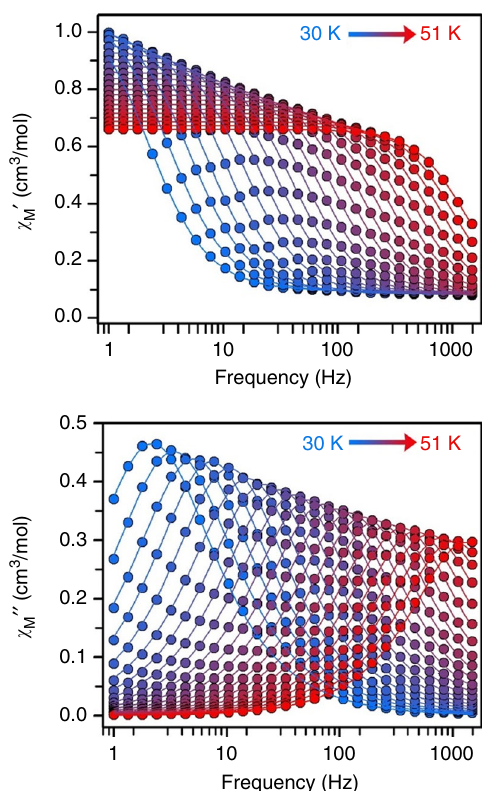
Fig. 3 Dynamic magnetic susceptibility data. Variable-temperature, variable-frequency in-phase ( χ M ′ ) and out-of-phase ( χ M ″ ) ac magnetic susceptibility data collected for 2-Tb under a zero-applied dc fi eld from 30 to 51 K. A non-zero χ M ″ out-of-phase signal suggests the presence of an energy barrier to spin reversal. Fits of a generalized Debye function to the χ ′ and χ ″ data afforded the relaxation times; solid lines represent fi ts to M M the data. Low and high-frequency ac magnetic susceptibility data are shown in the Supplementary Figs. 46 and isostructural compounds 2-Tb and 2-Dy are THF-free, resulting in decreased metal coordination numbers and increased Ln – N 2 3 − – Ln dihedral angles of 178.5(2)° and 178.9(3)°, compared to 173.45(16)° and 173.14(8)° in 1-Tb and 1-Dy , respectively (Fig. 1 and Supplementary Fig. 3). The analogous reaction with 1-Gd